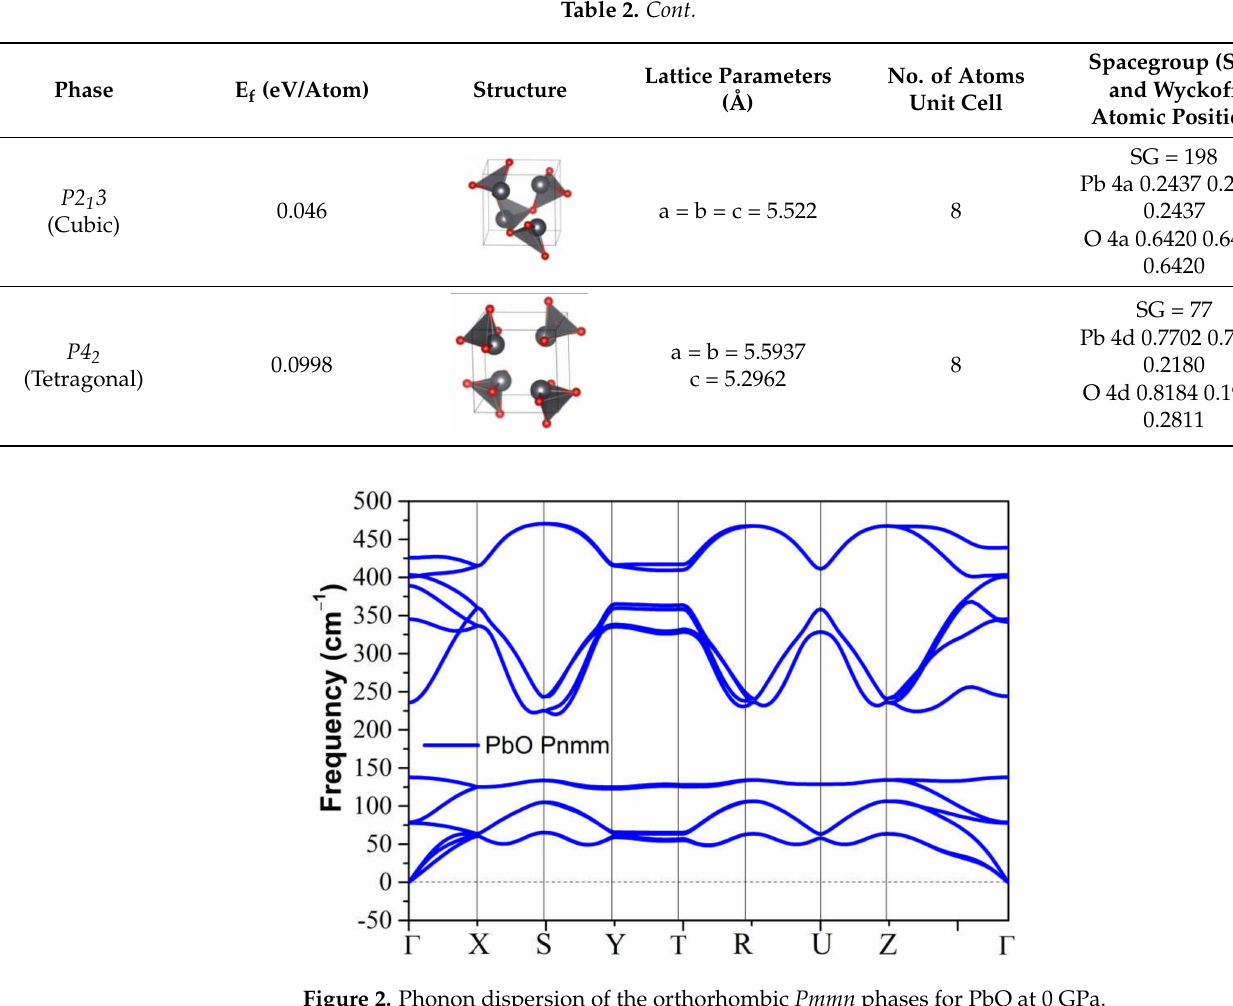
Figure 2. Phonon dispersion of the orthorhombic Pmmn phases for PbO at 0